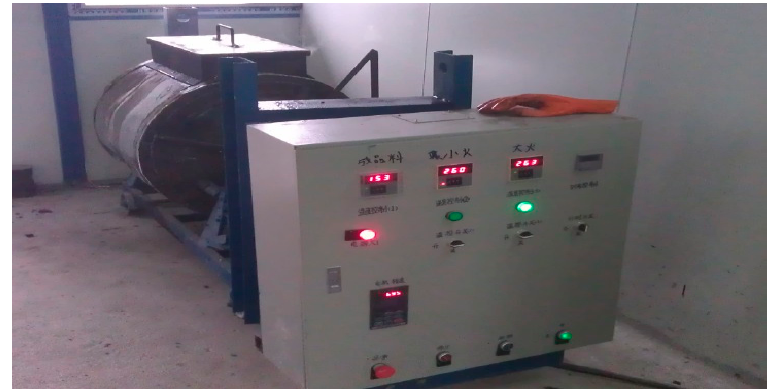
Figure 1. Cooker simulating mixer.